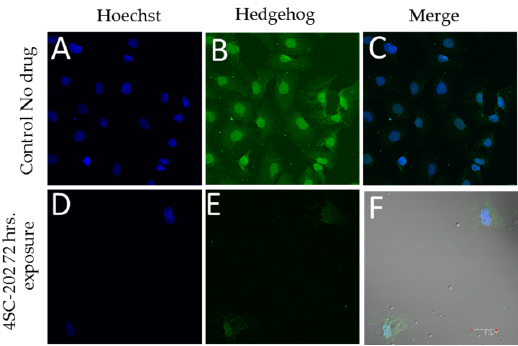
Figure 3. 4SC-202 reduces Hedgehog expression in DAOY medulloblastoma. Hedgehog immunoreactivity is present in control (0.001% DMSO) ( B ) treated DAOY but significantly reduced in DAOY treated with 4SC-202 for 72 h. ( E , white arrows). The number of nuclei was significantly reduced following 4SC-202 exposure due to the cytotoxicity of 4SC-202 as assessed by staining with Hoechst dye ( D ) when compared to the number of nuclei in control treated DAOY ( A ). Colocalization of Hoechst and Hedgehog immunoreactivity is illustrated in control treated DAOY ( C ) and 4SC-202 treated DAOY ( F ), showing fewer hedgehog immunoreactivity treatment following 4SC-202 treatment. Scale bar = 50 microns.